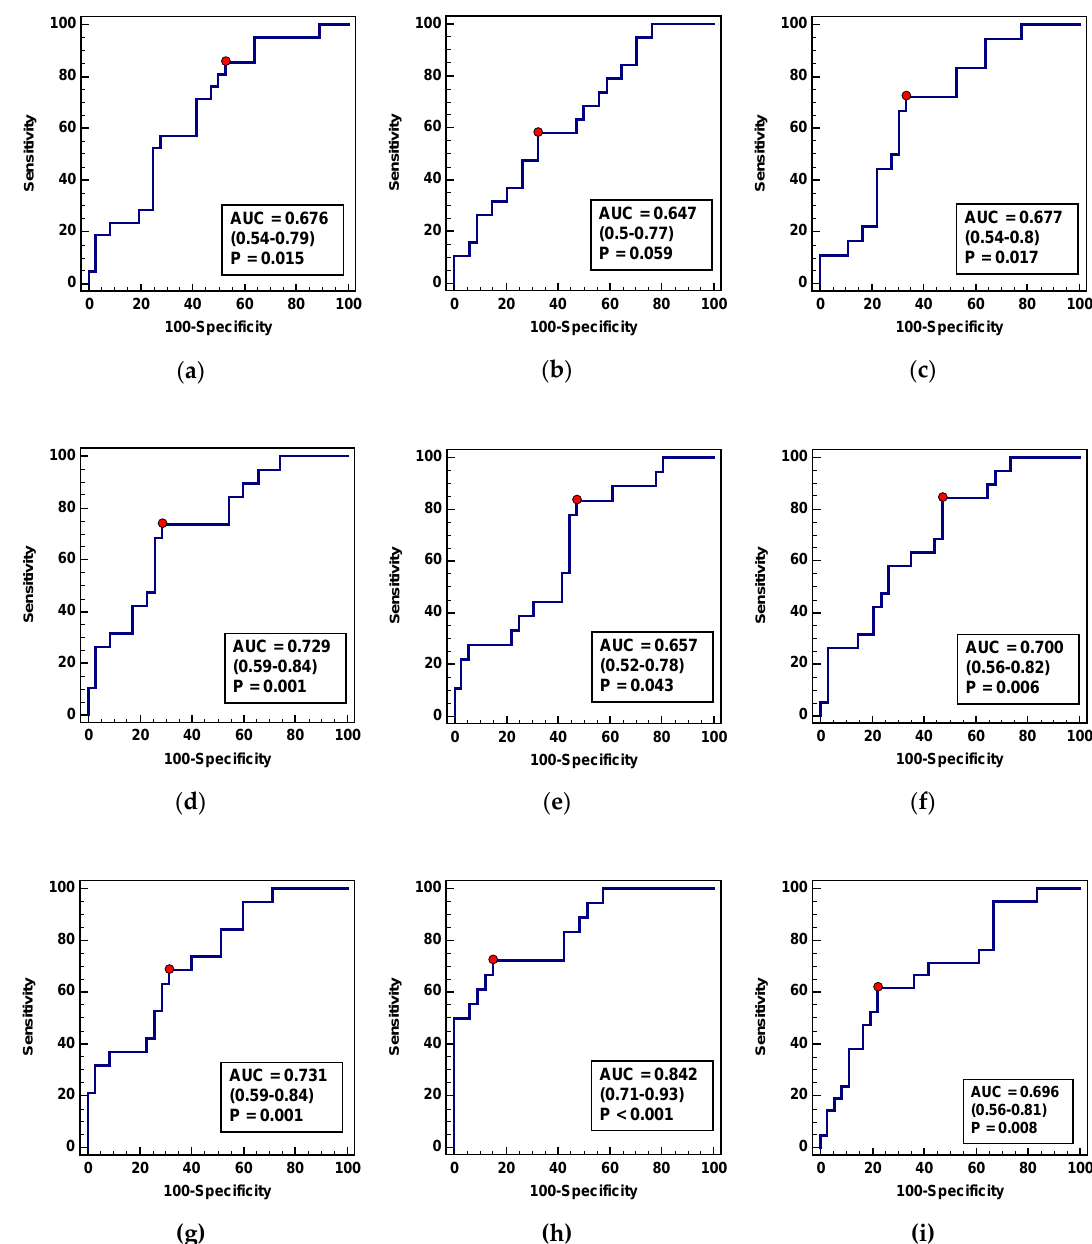
Figure 13. L-arginine/NO pathway metabolites as RoBF ≥ 5 predictors: ( a ) Arg- Δ 24/0 ; ( b ) Arg- Δ 72/24 ; ( c ) ADMA- Δ 72/0 ; ( d ) ADMA- Δ 72/24 ; ( e ) SDMA- Δ 72/0 ; ( f ) SDMA- Δ 72/8 ; ( g ) SDMA- Δ 72/24 ; ( h ) a panel consisting of Arg- Δ 24/0 , Arg- Δ 72/0 , ADMA- Δ 24/8 , and SDMA- Δ 72/24 —ratios of metabolites selected in the logistic regression analysis as variables independently from others associated with delayed restoration of bowel function (RoBF ≥ 5 days); ( i ) Arg/ADMA- Δ 24/0 . Arg: Arginine; ADMA: Asymmetric dimethylarginine; SDMA: Symmetric dimethylarginine; AUC: Area under receiver operating characteristic (ROC) curve. Data presented as AUC with a 95% confidence interval and p -value for difference from AUC = 0.5 characterizing a chance marker. Table 13. Characteristics of L-arginine/NO pathway metabolites as predictors of postoperative ileus. Marker Criterion Sens. and Spec.